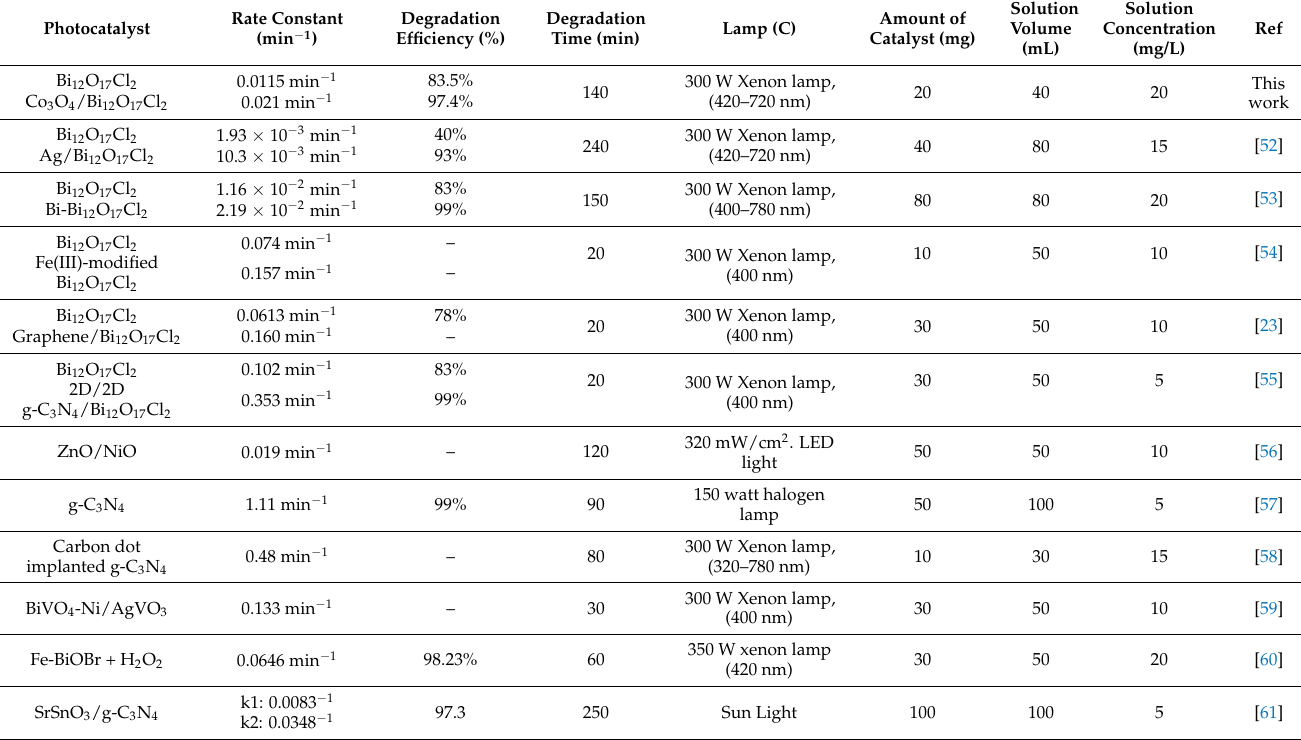
Table A1. Comparison of photocatalytic degradation of RhB in the presence of pure BOC and BOC composite sample with recently reported results.